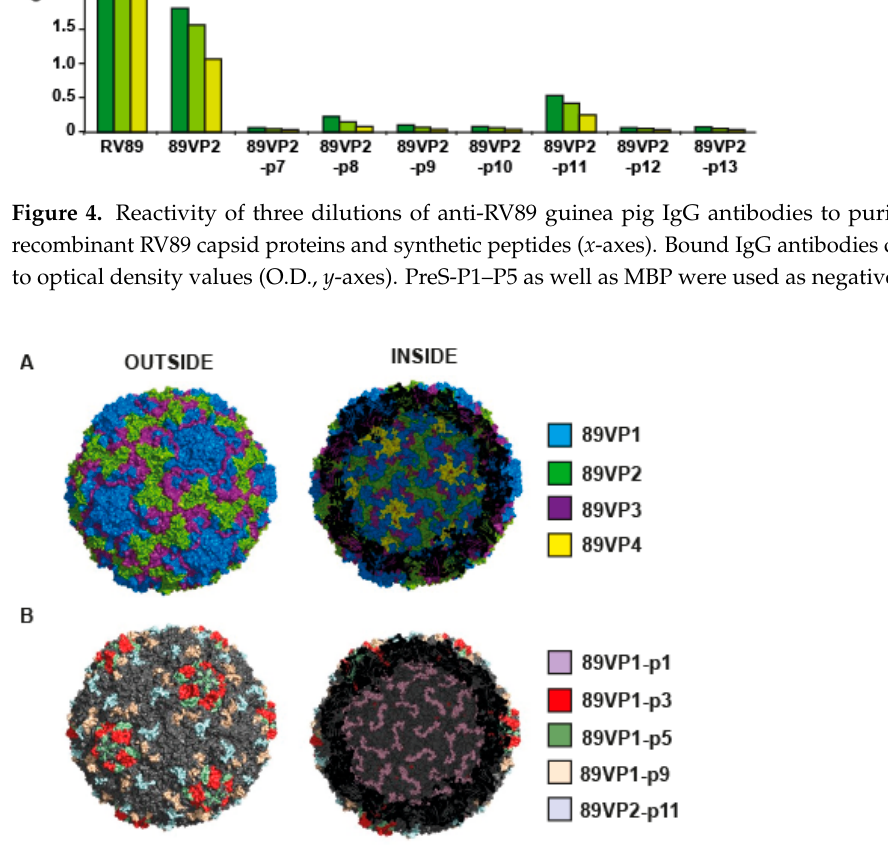
Figure 5. Localization of VP1- and VP2-derived peptides in the model of the three-dimensional structure of the capsid of RV16. Outer (left images) and inner (right images) surface representations with (A) VP1-4 and (B) with VP1- and VP2-derived peptides highlighted in different colors.